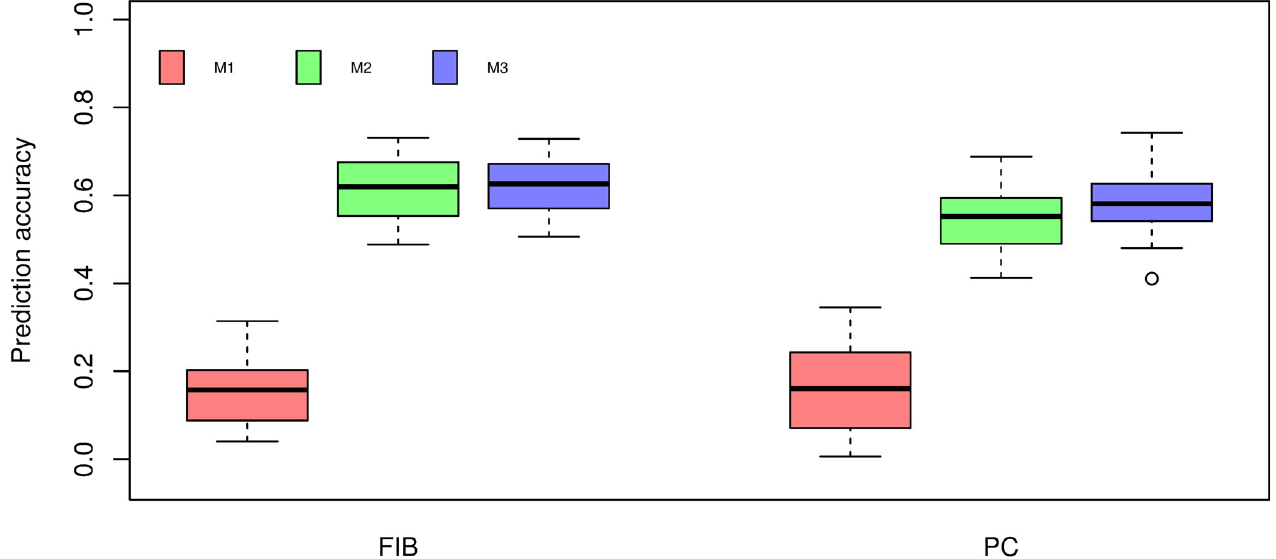
Fig 4. Box-plot of cross-validation prediction accuracy of fiber content (FIB) and sucrose content (PC) using BayesB under three different prediction models. M1: Markers. M2: Near-infrared spectra. M3: The combination of markers and near-infrared spectra. Different lowercase letters denote significant differences with Tukey’s test ( P <